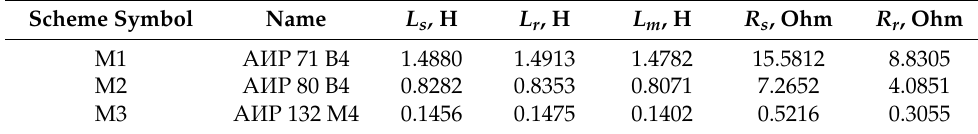
Table 2. Parameters of the motor substitution diagram.